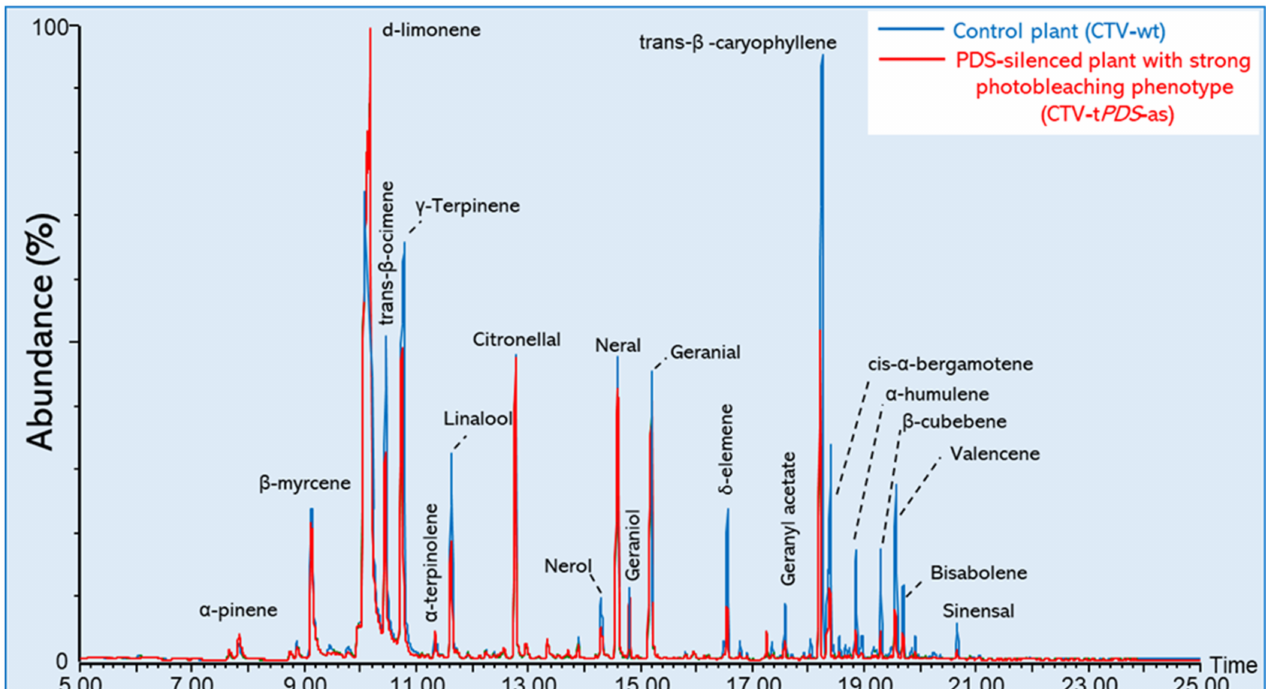
Figure 2. Overlayed total ion chromatograms (TICs) of released volatiles from citrus leaves separated by gas chromatography-mass spectrometry (GC-MS) analysis. The green peaks indicate released leaf volatiles from the control plants (CTV-wt), while red peaks indicate released leaf volatiles from PDS-silenced plants (CTV-t PDS -as) with a strong photobleaching phenotype.